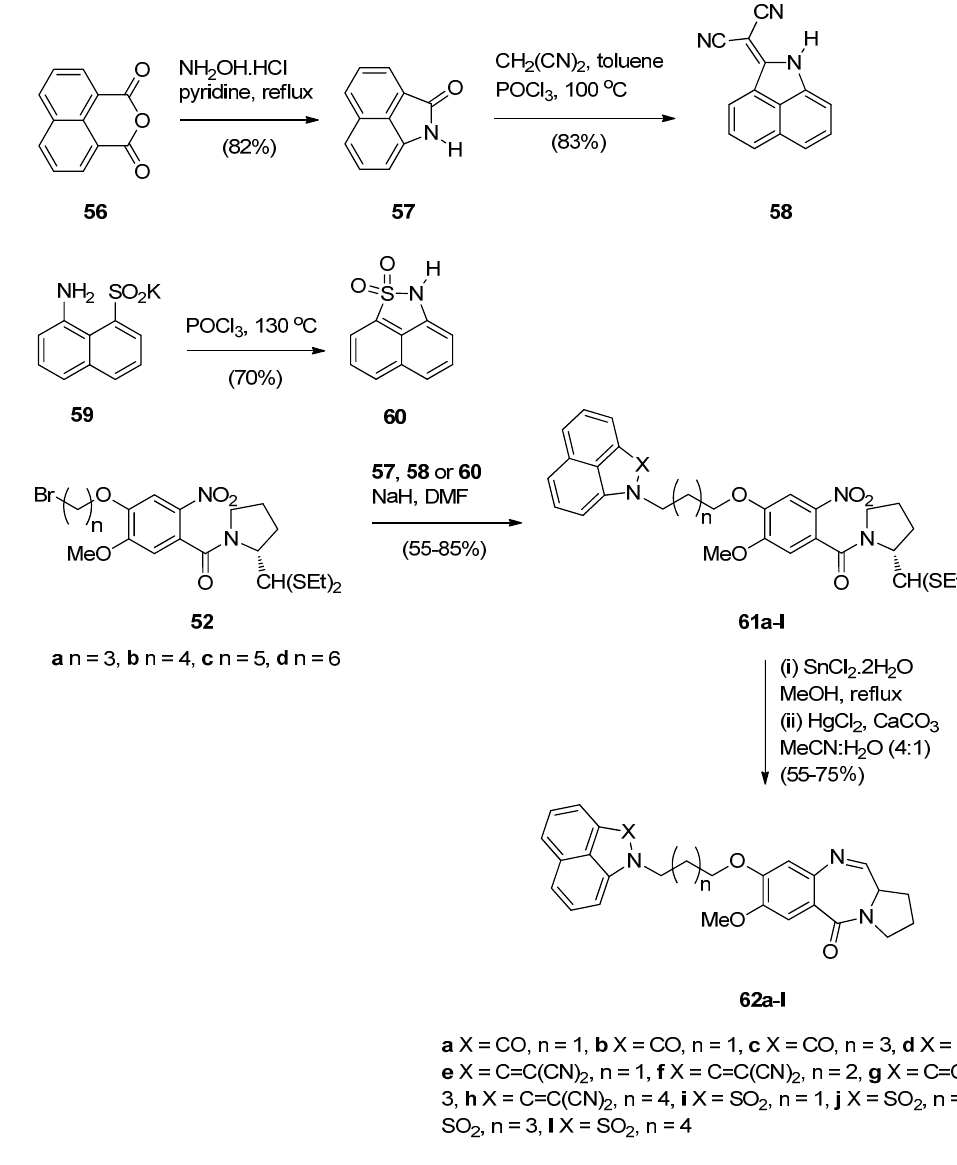
Scheme 10. Synthesis of C8- O -substituted PBD conjugates 62a – l .